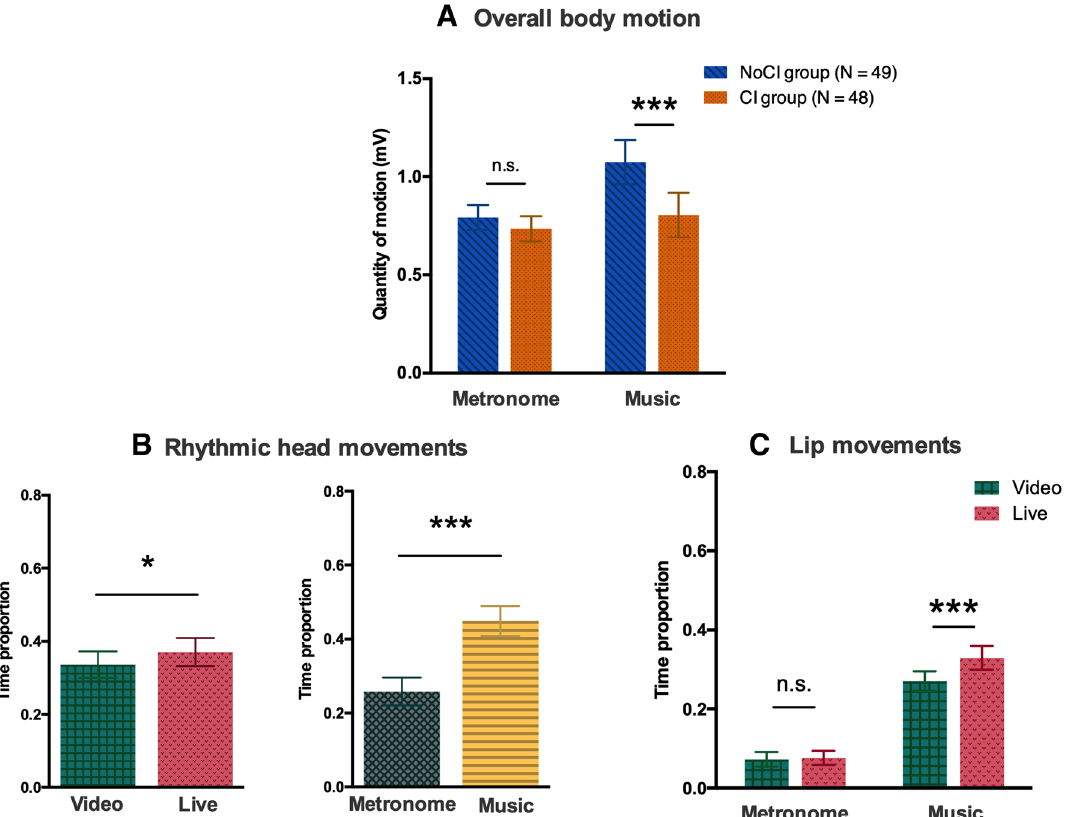
Figure 4. Spontaneous motor behaviors. ( A ) Mean ± standard error of the mean (SEM) overall body motion as a function of the sound sequence (metronome or music) and the group (CI/NoCI). In the music condition, participants in the CI group produced less overall body motion than participants in the NoCI group. The NoCI group producing more overall body motion when listening to the musical sequence than when listening to a metronome. In contrast, overall body motion in the CI group did not depend on the sound sequence. ( B ) Mean ± SEM time proportion of rhythmic head movements, as a function of the social context (video or live) and the sound sequence (metronome or music). Participants produced more frequent rhythmic head movements in the live condition than in the video condition (left graph) and more when listening to music than when listening to the metronome sequence (right graph). ( C ) Mean ± SEM time proportion of lip movements, as a function of the social context (video or live) and the sound sequence (metronome or music). Participants moved their lips less frequently when listening to the metronome than when listening to music. With music, participants moved their lips more frequently in the live condition than in the video revealed a significant main effect of the SOCIAL CONTEXT (F (1,95) = 4.18, p < 0.05, η 2 p = 0.042). Participants made more rhythmic head movements in the live condition than in the video condition (Fisher’s post-hoc test: p < 0.05; Fig. 4B). There was also a significant main effect of the AUDIO (F (1,95) = 61.60, p < 0.001, η 2 p = 0.39). Par- ticipants made more rhythmic head movements when listening to music than when listening to a metronome (post-hoc Fisher’s test: p < 0.001). There were no effects of GROUP and no interactions. Lip movements. A three-way ANOVA was conducted on the time proportion of lip movements with the between-subjects factor GROUP (two levels: CI/NoCI) and the within-subjects factor AUDIO (two levels: met- ronomic/musical) and SOCIAL CONTEXT (two levels: video/live). The analysis revealed a significant inter- action between the factors AUDIO and SOCIAL CONTEXT (F (1,95) = 6.15, p < 0.05, η 2 p = 0.061; Fig. 4C). Par- ticipants sang more when listening to music than when listening to a metronome. When listening to music, participants sang more in the live condition than in the prerecorded condition (Fisher’s post-hoc test: p < 0.001). When listening to a metronome, SOCIAL CONTEXT did not impact the participants’ singing time. The results also showed significant main effects of AUDIO (F (1,95) = 70.09, p < 0.001, η 2 p = 0.43), and SOCIAL CONTEXT (F (1,95) = 8.73, p < 0.01, η 2 p = 0.084). There was no effect of GROUP effect or any other interactions. Non-rhythmic head movements. A three-way ANOVA on the time proportion of non-rhythmic head move- ments with the between-subjects factor GROUP (two levels: CI/NoCI) and the within-subjects factor AUDIO (two levels: metronomic/musical) and SOCIAL CONTEXT (two levels: video/live) did not show any main effects or significant interactions.